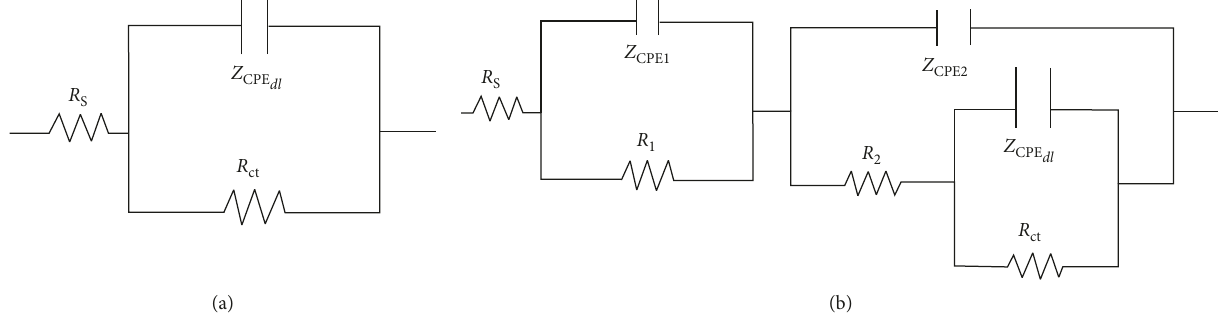
Figure 8: Proposed equivalent circuits for modeling the impedance spectra: (a) without the addition of Nd 3+ ions and (b) with the addition of Nd 3+ ions.